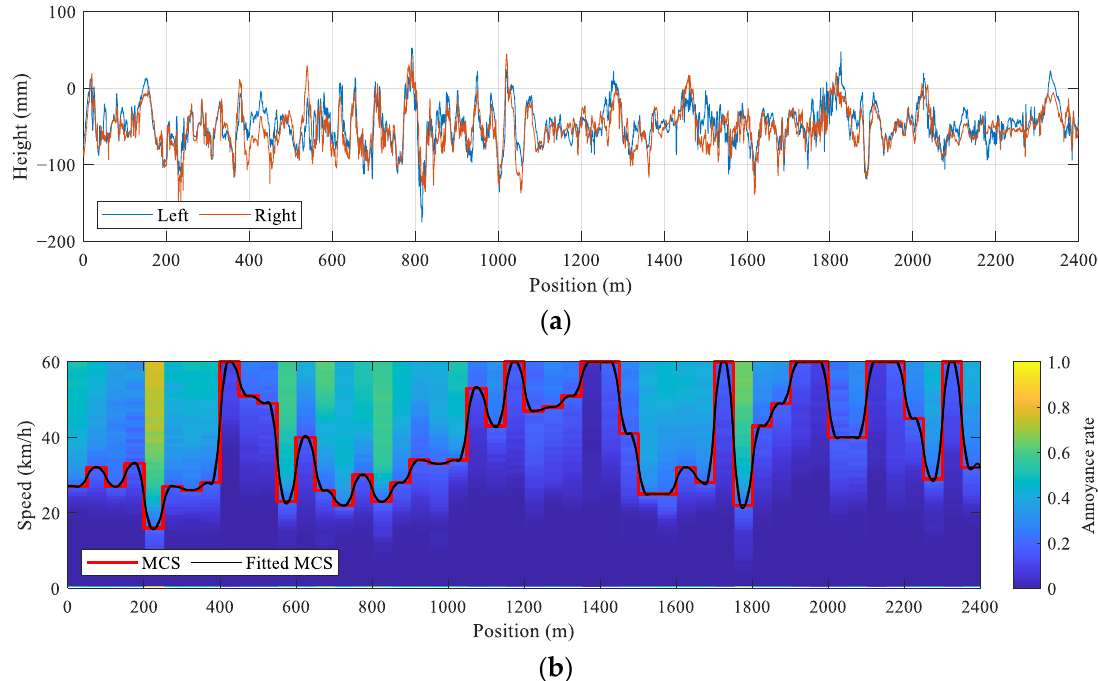
Figure 7. Sampled rough pavement for testing: ( a ) road profiles, and ( b ) annoyance rate and MCS.